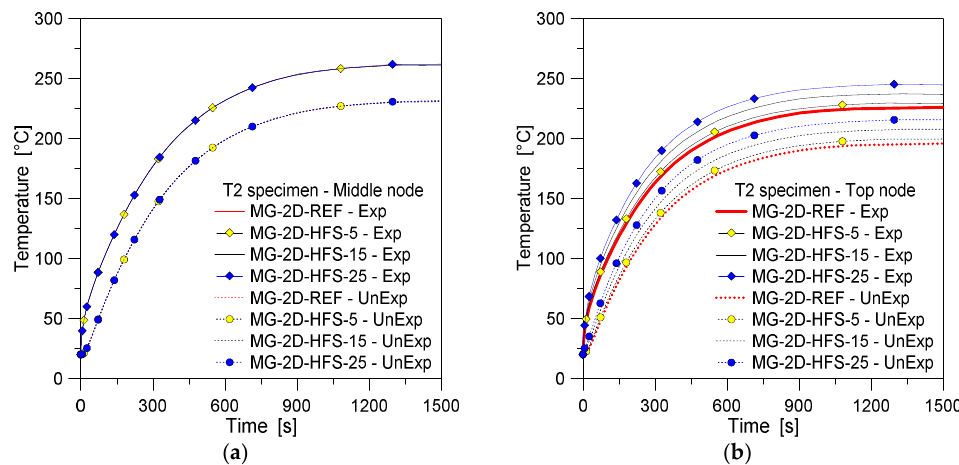
Figure 13. FE results (ABAQUS, 2D) for the MG specimen T2, by changing the thermal loading configuration of the sample top/bottom edges. Temperature history comparisons at the ( a ) middle and ( b ) top edge nodes.